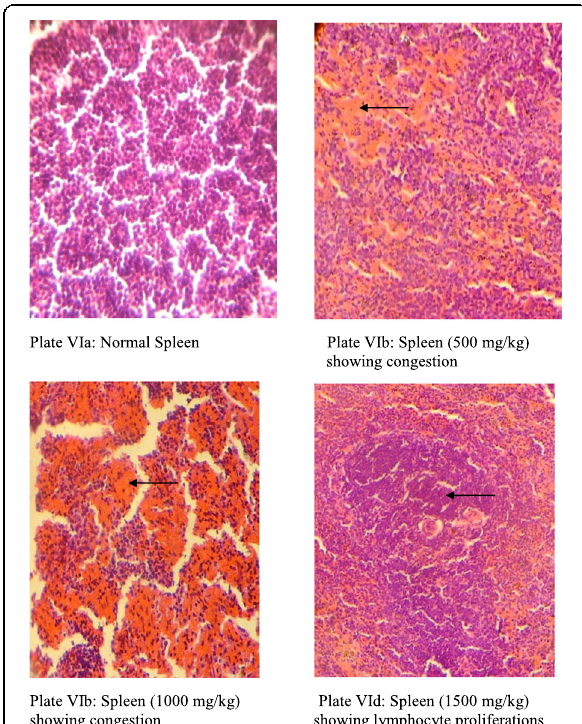
Fig. 6 Photomicrograph of the spleen of rats administered ethanol extract of Spondias purpurea leaf (H and E × 200). a Normal Spleen. b Spleen (500 mg/kg) showing congestion. c Spleen (1000 mg/kg) showing congestion. d Spleen (1500 mg/kg)